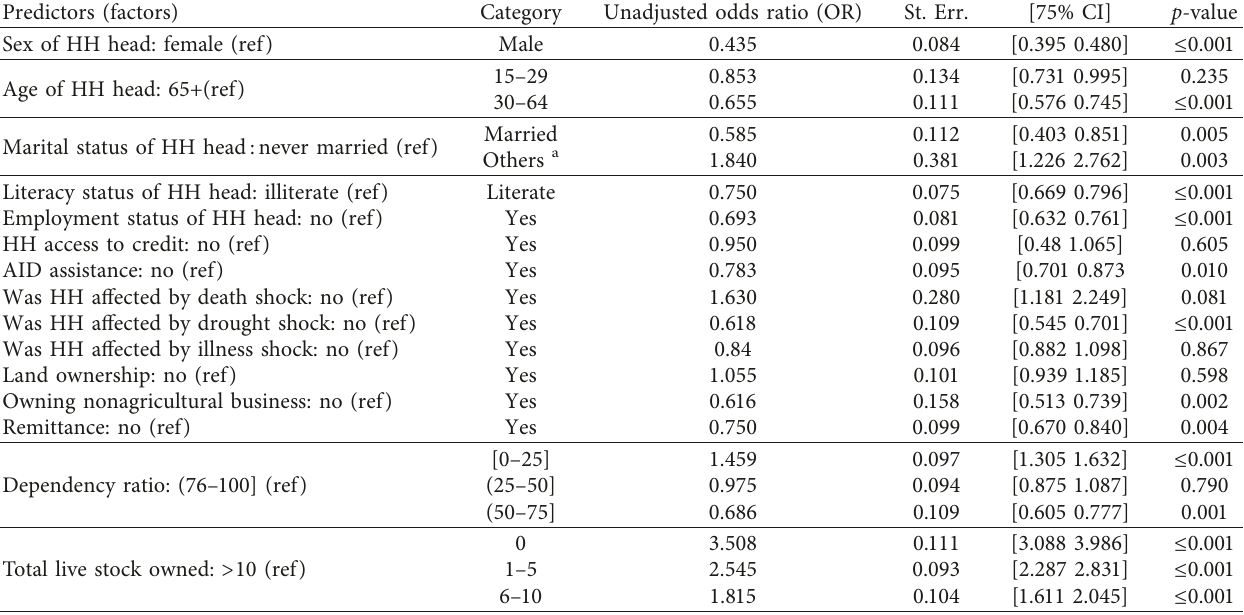
Table 4: Logistic regression result of one predictor variable on household (HH) food insecurity status (bivariate analysis) at 25% level of